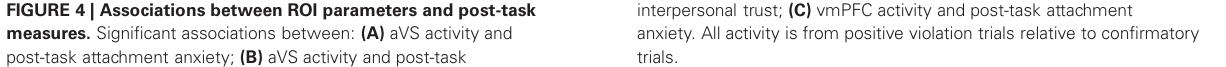
interpersonal trust; (C) vmPFC activity and post-task attachment anxiety. All activity is from positive violation trials relative to confirmatory